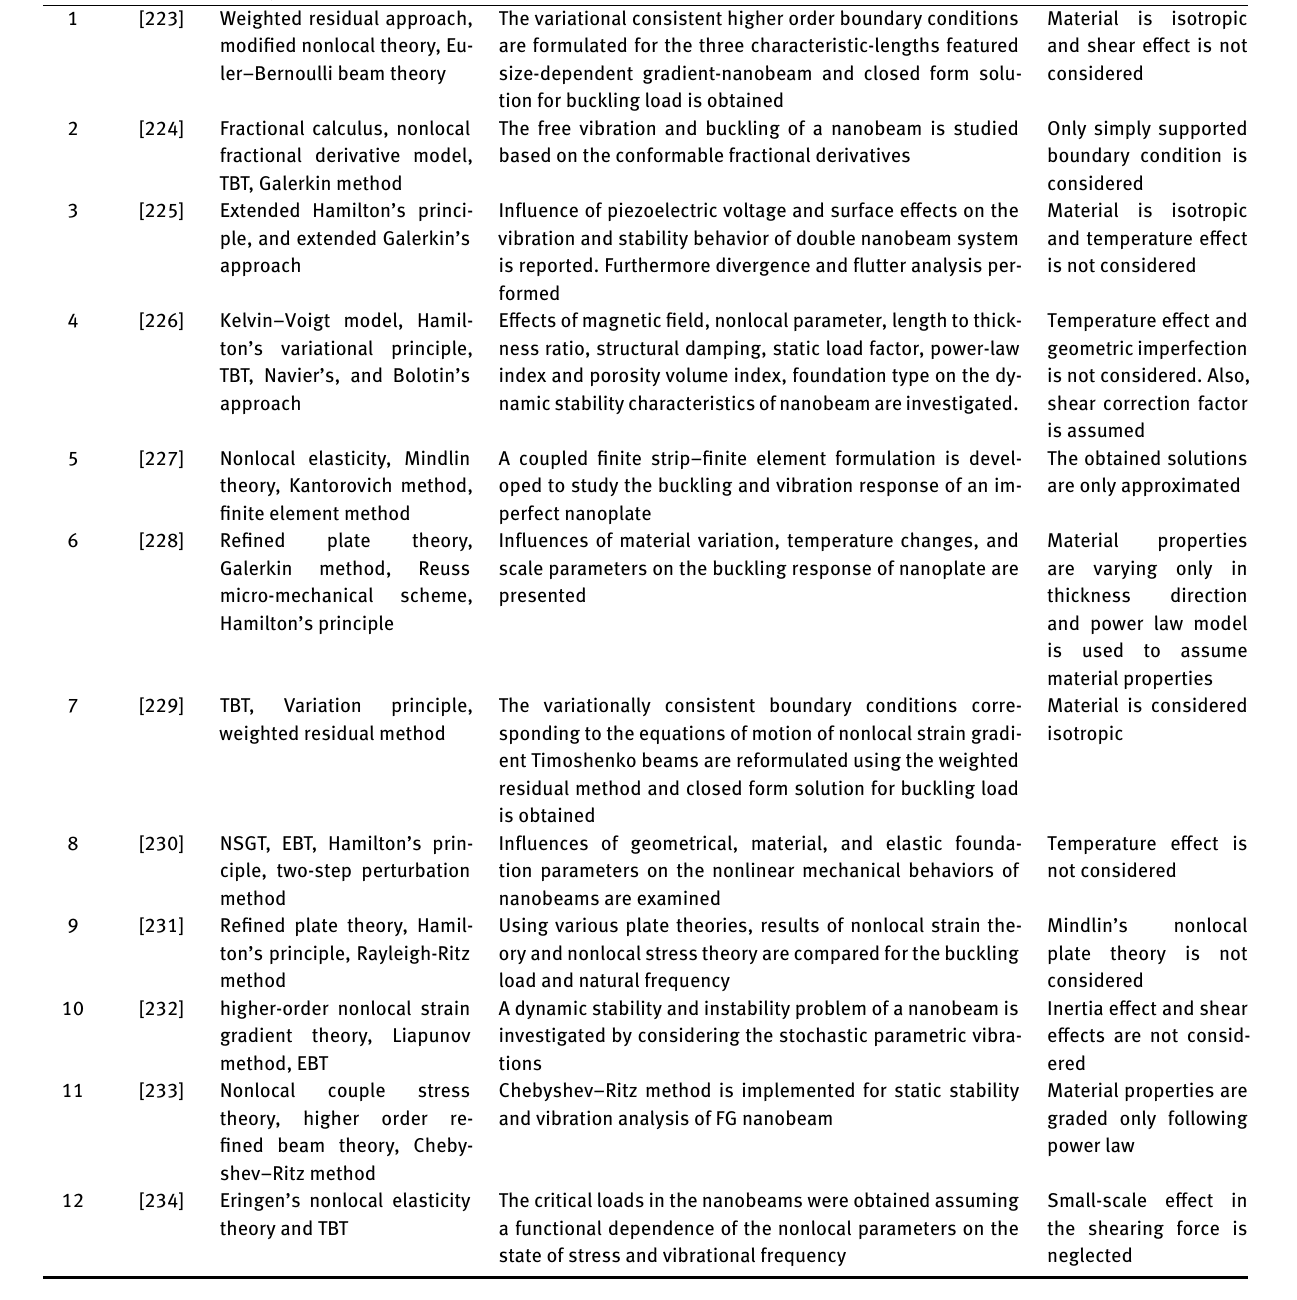
Table 3: Representation of published articles on analysis of nanobeams/nano plates/nanoshell using nonlocal elasticity. Sr no.